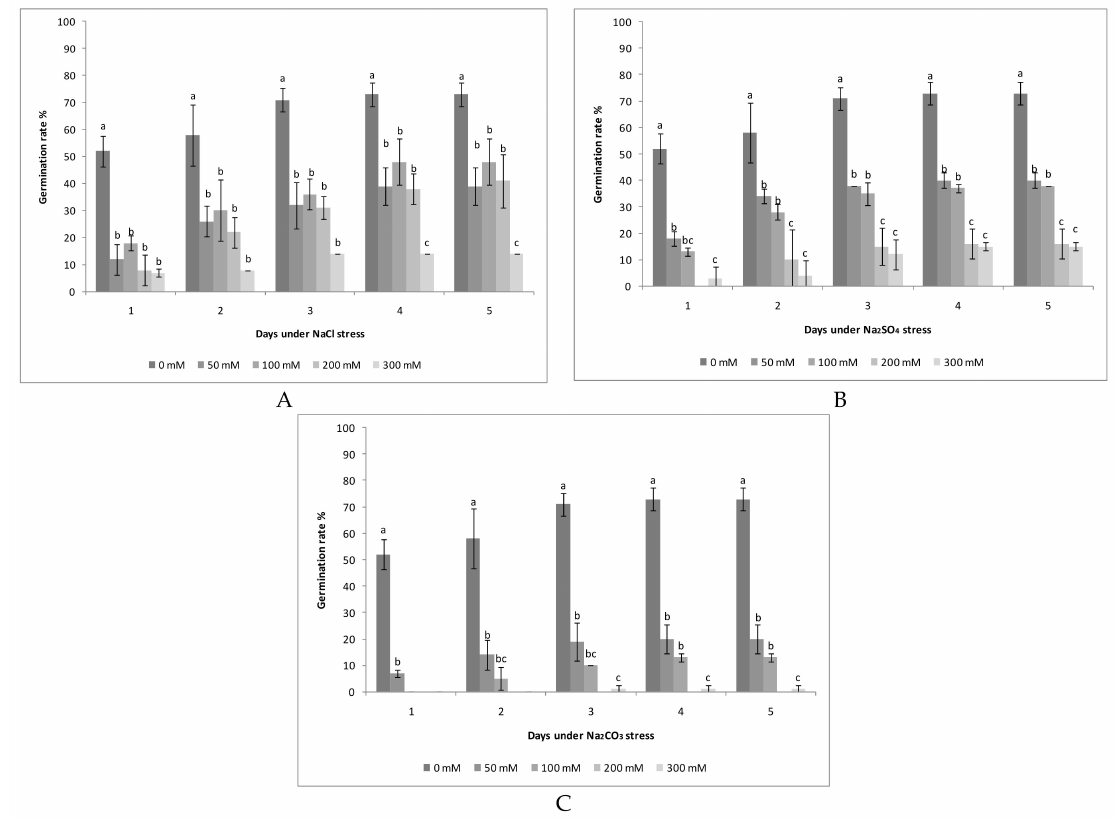
Figure 1. Seed germination rate of Titicaca cultivar under NaCl ( A ), Na 2 SO 4 ( B ) and Na 2 CO 3 ( C ) stresses. Di ff erent letter means significant di ff erences, according to Tukey test. Error bars indicate mean ±